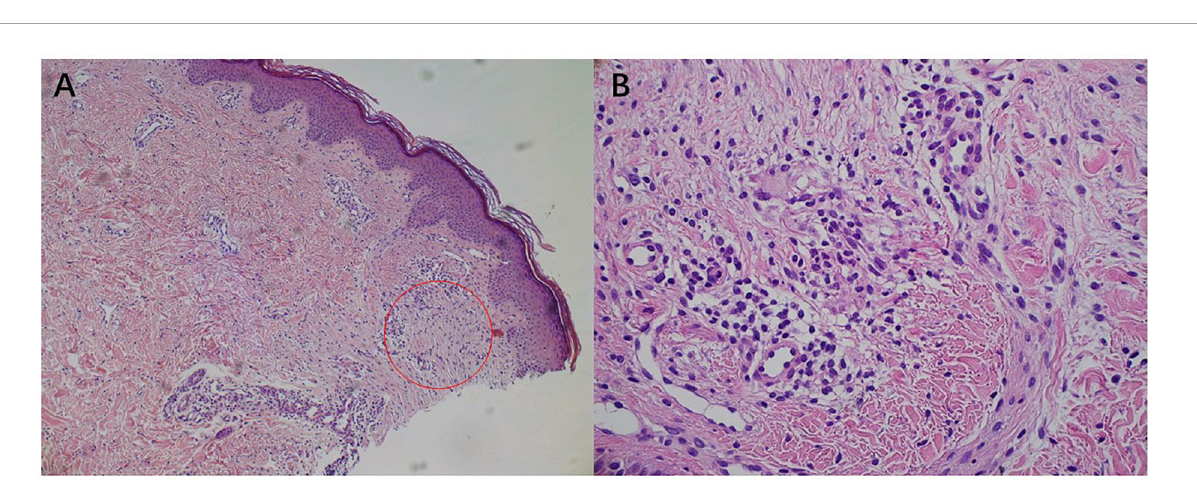
FIGURE4 Skin biopsy showed immature blasts infiltrate. (A) Hematoxylin-eosin stain; original magnification, × 100. (B) Hematoxylin-eosin stain; original magnification, × 400.